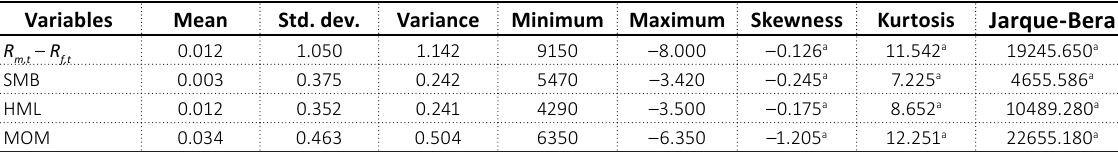
Table A1. Descriptive statistics of explanatory variables Variables Mean Std.